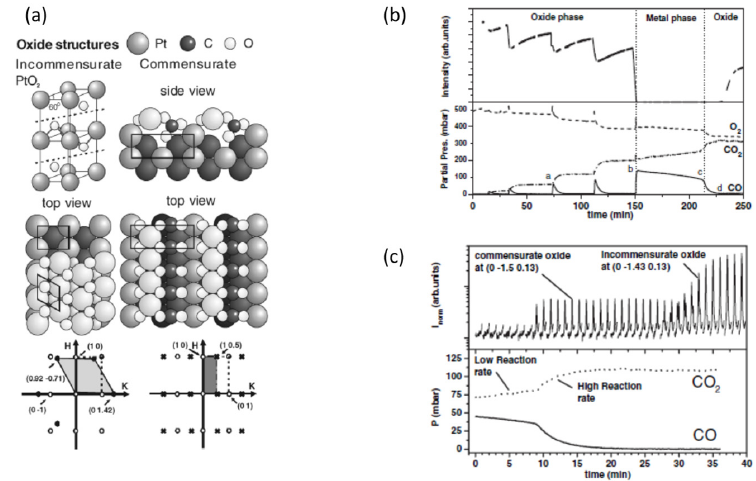
Figure 5. ( a ) The surface oxides (incommensurate and commensurate) identified by Ackermann et al. [116] to be to present during elevated pressure CO oxidation over Pt(110) using operando SXRD in the apparatus shown in Figure 4 and in both real and reciprocal space. ( b ) Correlating the mass spectrometric responses observed during CO pulsing into the O 2 backfilled reaction vessel with the X-ray diffraction intensity measured at a position in reciprocal space corresponding to the commensurate α -PtO 2 monolayer structure (0, 1.42, 0.5—see also bottom panel Figure 5a at 625 K. ( c ) Correlation of two regimes of CO oxidation catalysis with X-ray diffraction intensity measured at two positions in reciprocal space corresponding to the commensurate and incommensurate oxide structures shown in 5a and also at 625 K. Reproduced with permission from Phys. Rev. Letts . 2005 , 95 , 255505 [116]. Copyright 2005, American Physical Society.